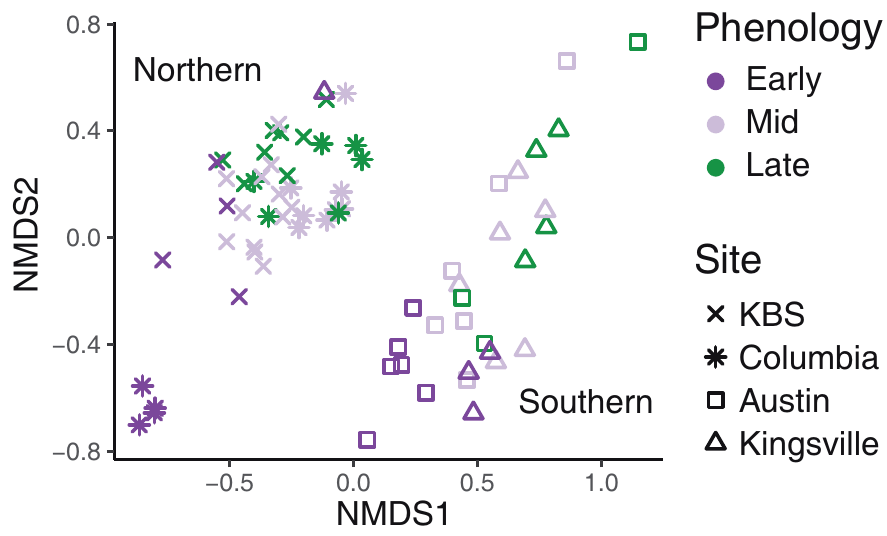
Fig 2. Site-specific changes in microbial communities shown by NMDS. Genotypes were sampled at 4 sites. From north to south: KBS, Michigan; Columbia, Missouri; Austin, Texas; and Kingsville, Texas. Northern sites are shown by symbols, and southern by open shapes. Color indicates phenological stage sampled, “Early” samples were taken just after emergence, “Mid” samples were taken during seed development, and “Late” samples were taken after senescence began. Data underlying this figure can be found in S2 Data. NMDS, nonmetric multidimensional